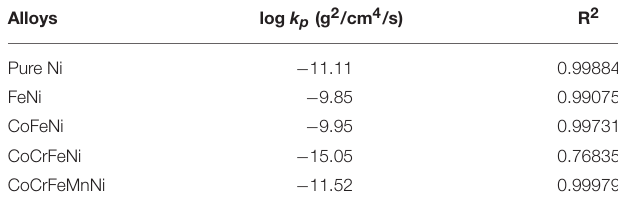
TABLE 2 | log k p of the alloys oxidized in air at 800 ◦ C.